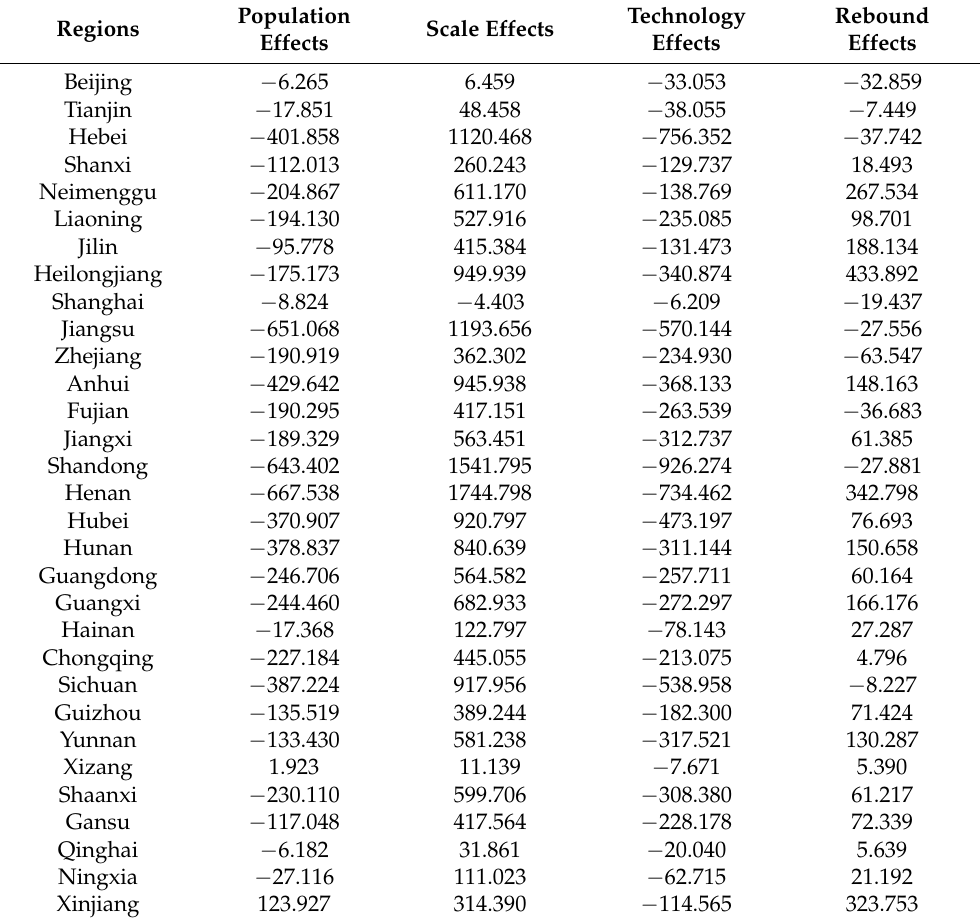
Table A4. The influence of various effects on carbon emissions (10 4 t) from the planting industry in rural China.